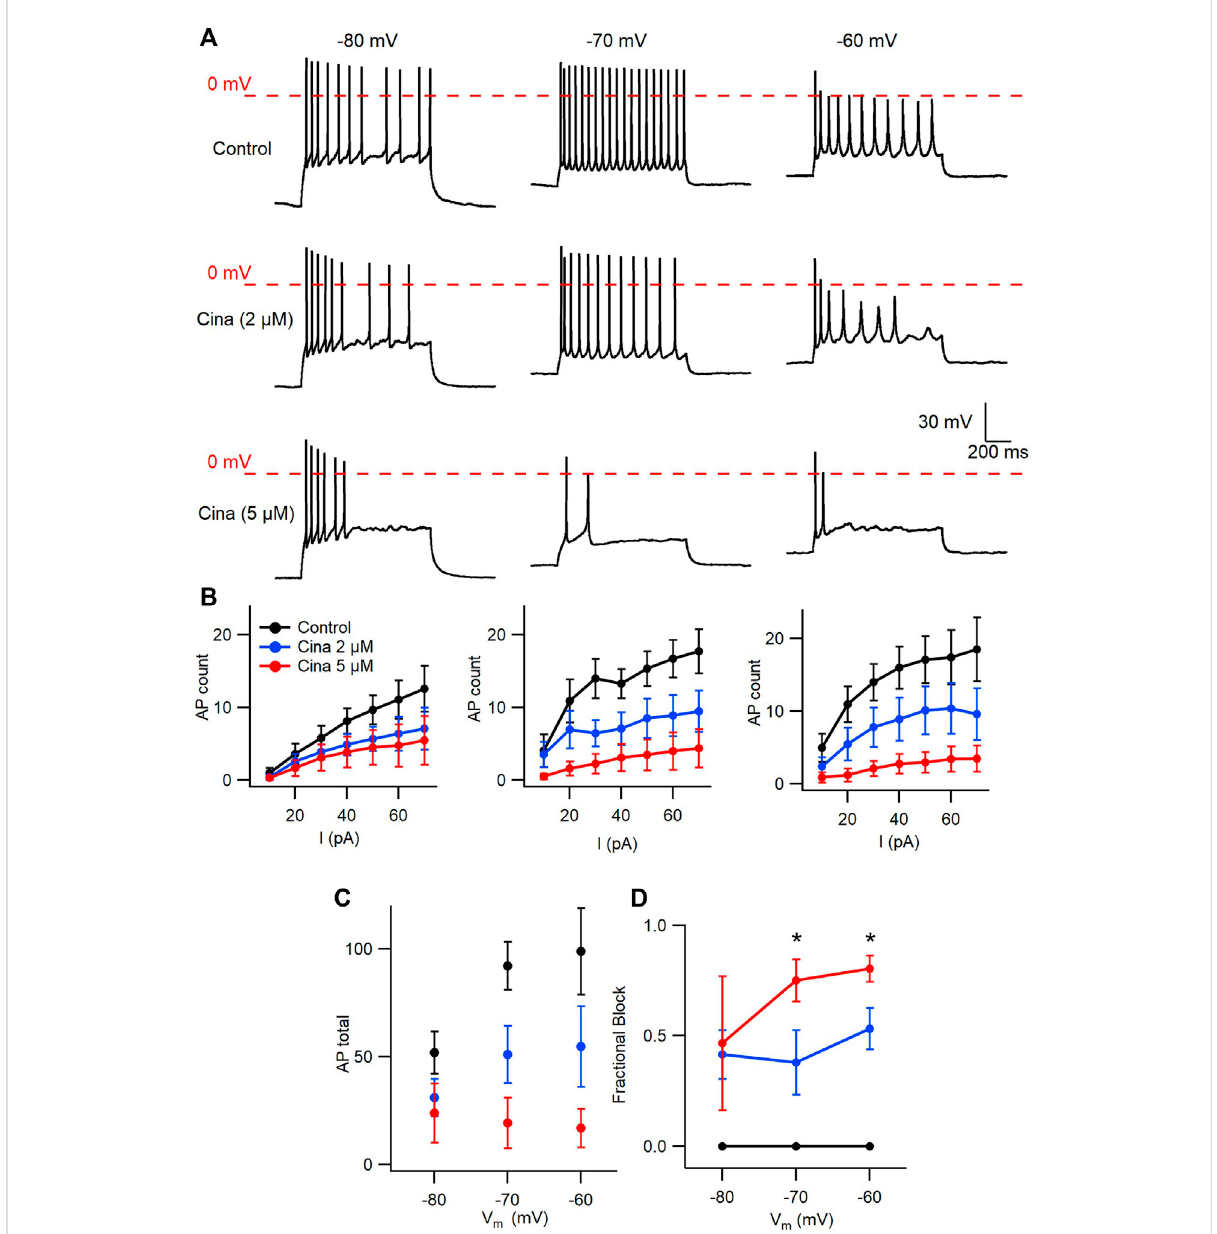
FIGURE 6 Voltage-dependentinhibitionofspikegenerationbycinacalcet. (A) Exemplartracesshowingvoltage-andconcentration-dependentinhibition by cinacalcet. Three whole-cell current clamp recordings with holding potentials at − 80 mV, − 70 mV and − 60 mV. Measurements were taken at 70 pA before and after cinacalcet was applied for 5 min at incremental doses of 2 μ M and 5 µM. (B) Action potential (AP) count following serial current injections from 10 pA to 70 pA for 1 s at holding potentials of − 80 mV, − 70 mV and − 60 mV (from left to right) showing decrease in average AP number with increasing cinacalcet dose from control (black), 2 µM (blue) and 5 µM (red) as well as increased separation of the curves as more depolarizedholdingpotentials. (C) Plotdemonstrating acomparison ofthecumulativenumber ofAPs as seen in (B) (D) Fractional Inhibition of AP during maximal current injection of 70 pA at each holding potential. The fractional inhibition with 5 µM cinacalcet increased from 46% to 75% – 80% with depolarization of holding potential from − 80 mV to − 70 mV to − 60 mV. In addition the dose-dependence of the fractional inhibition increasedinanon-linearmannerwithnodifferenceat − 80 mVbutshowedasigni fi cantincreaseininhibitionat − 70 mVand − 60 mVwithincreasing cinacalcet dose (mean fractional inhibition 42 ± 11% vs. 47 ± 30% at − 80 mV, 38 ± 15% vs. 75 ± 10% at − 70 mV, and 53 ± 9% vs. 80 ± 6% at − 60 mV at 2 µM and 5 μ M; n = 10 – 11 for all groups; ** p < 0.01 by paired